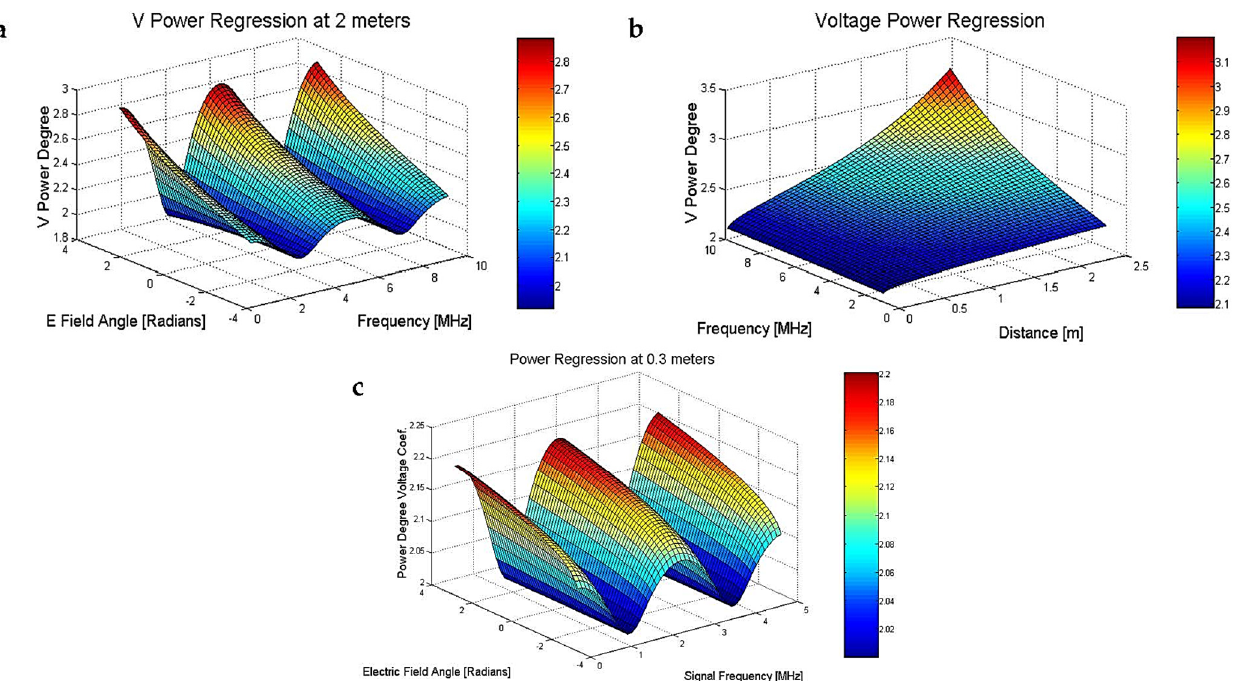
Figure 4. ( a ) Absolute power degree for voltage (+1 for the E field) function of the frequency spectrum (1–10 MHz) and an E field angle, in radians; ( b ) absolute power degree for voltage (+1 for the E electrical field) function of the frequency spectrum (1–10 MHz) and a transducer distance in m; ( c ) absolute power degree for voltage (+1 for the E field) at a fixed 0.3 m distance, function of the frequency spectrum (1–5 MHz) and an E field angle in radians.